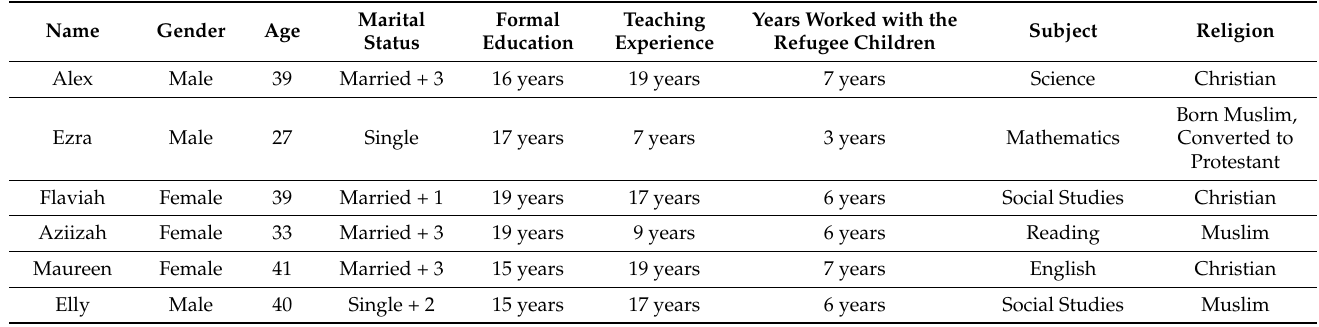
Table 1. Participants in this